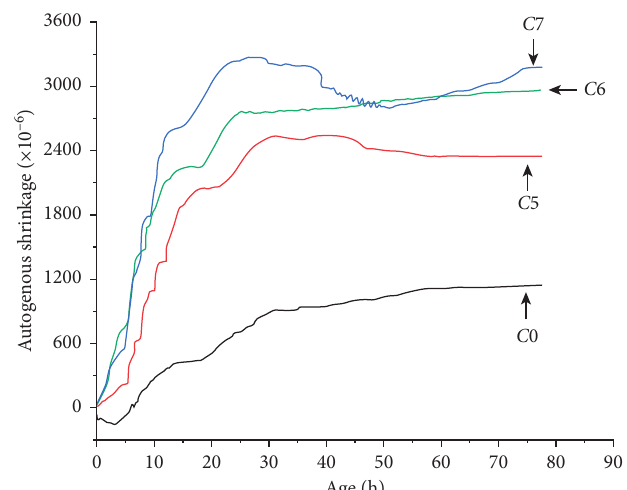
Figure 7: Effects of LC and NC combined additives on the autogenous shrinkage of UHPC ( C 0 � 0% LC and 0% NC; C 5 � 0.1% LC and 2%